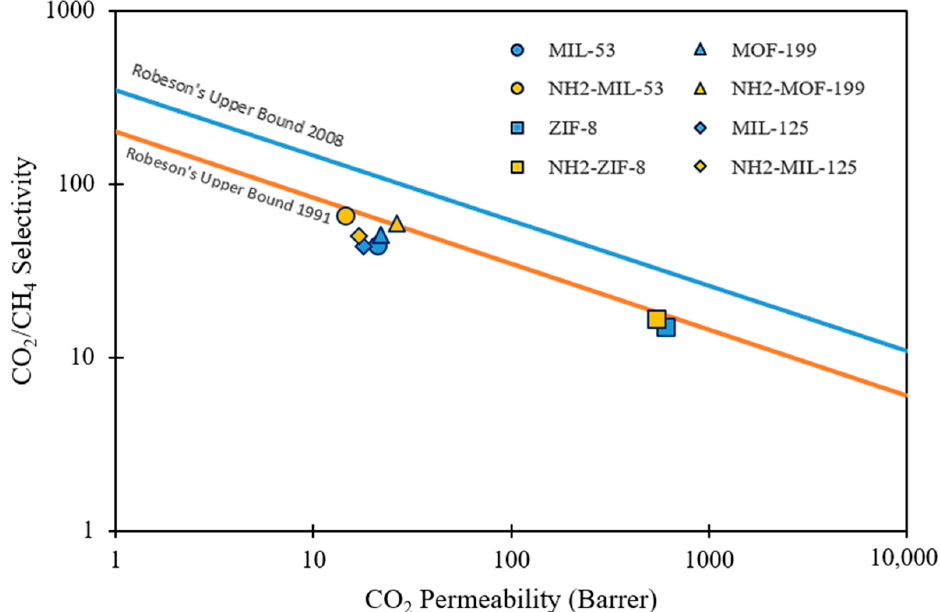
10 of 22 Figure 5. Cross-sectional SEM images of ( a ) UiO-66/6FDA-ODA and ( b ) NH 2 -UiO-66/6FDA-ODA [83].